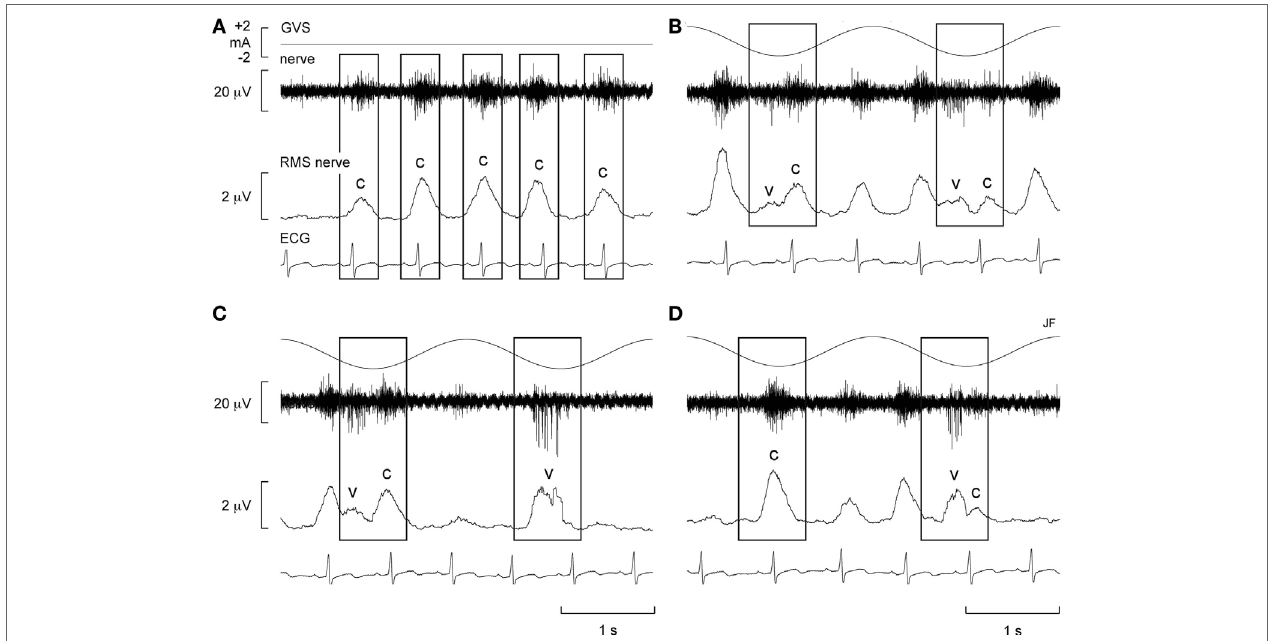
FiGURe 1 | Spontaneous muscle sympathetic nerve activity (MSNA) presented as the filtered neurogram (nerve) and as an RMS-processed signal (RMS nerve), shown with ECG at rest (A) and during sinusoidal GVS (sGVS) at 0.5 Hz (B–D) . Each panel spans a 4 s period. (B–D) Consecutive sequences obtained during sGVS at 0.5 Hz to illustrate the coupling of MSNA to the ECG and to the vestibular input. The rectangles illustrate the relationship between the sympathetic burst and the cardiac rhythm (c) and the vestibular rhythm (v). Reproduced with permission from Bent et al. (46). FiGURe 2 | Experimental records of muscle sympathetic nerve activity (MSNA) from one subject during sinusoidal GVS (sGVS) at 0.8 Hz, showing super entrainment of MSNA to the sinusoidal vestibular input. The highlighted section in panel (A) is shown expanded in panel (B) . (C) Delivery of sGVS to the shoulders (anode on right shoulder, cathode on left). Reproduced with permission from Macefield and James (47).